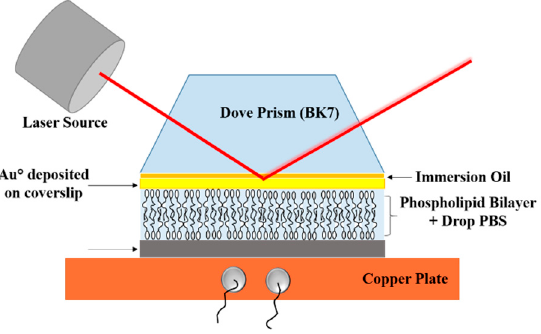
Figure 1. Schematic diagram of Surface Plasmon Resonance (SPR) assembly used for the experiments.